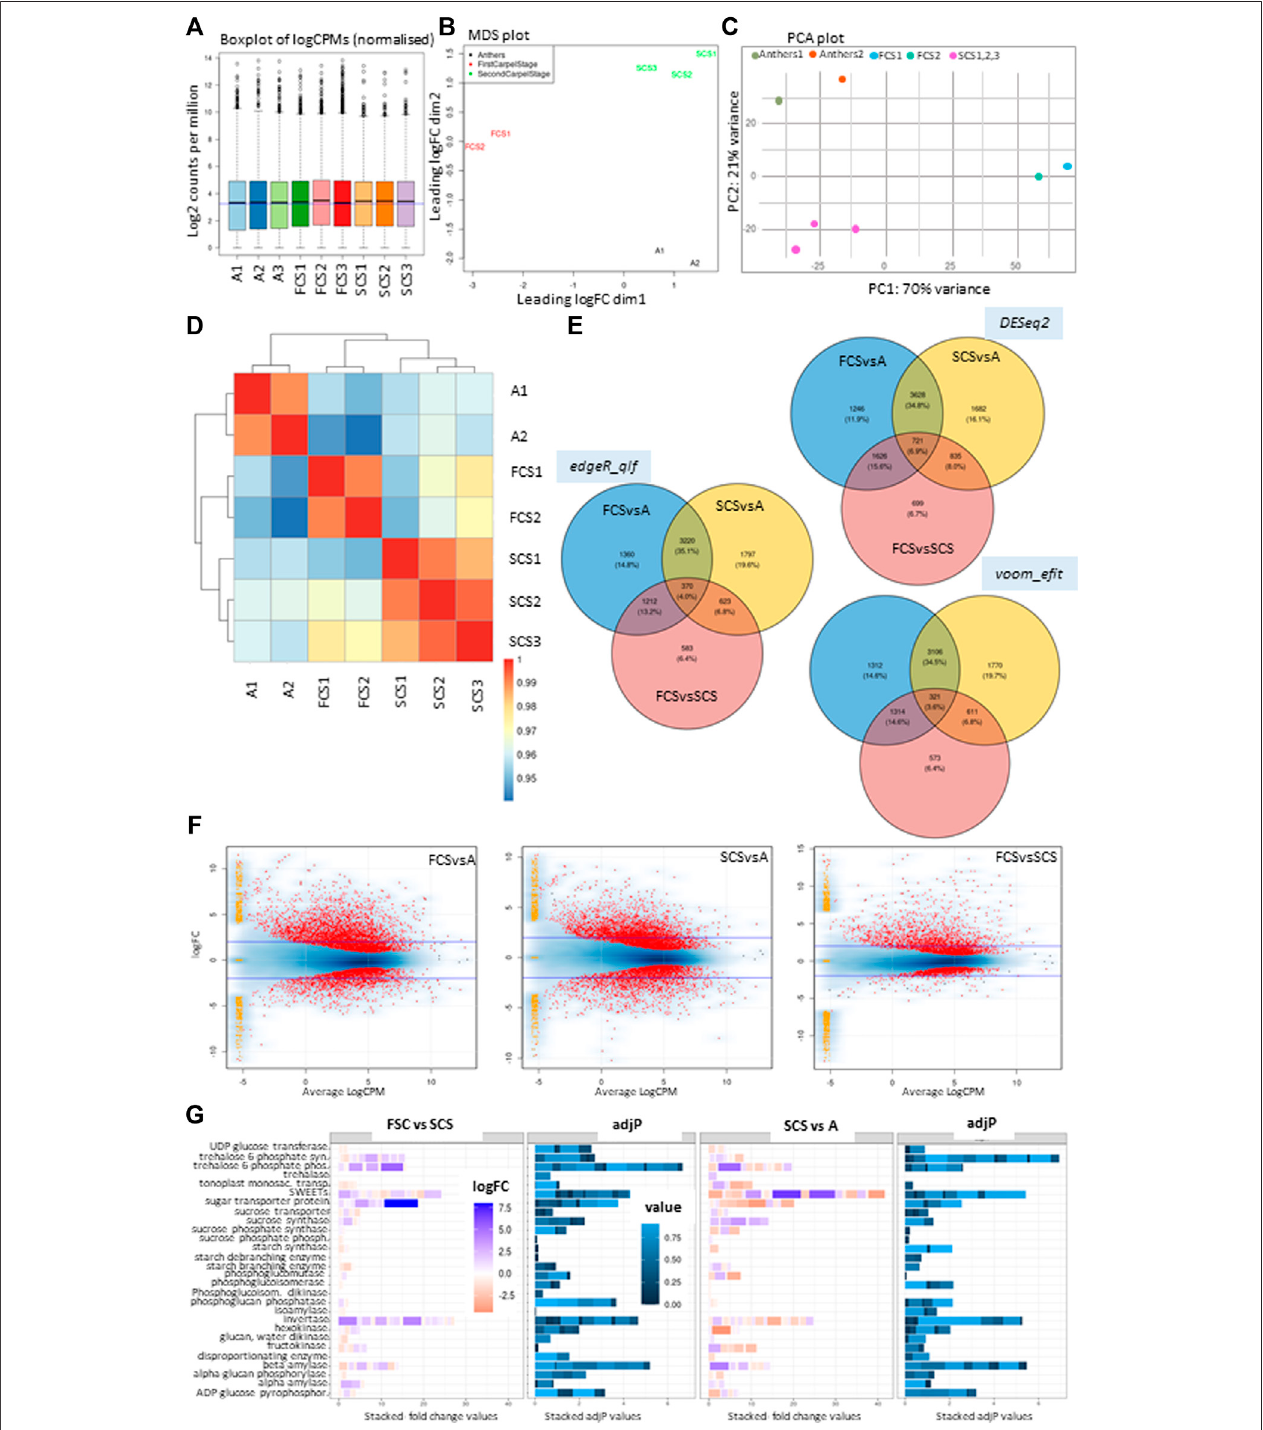
FIGURE2| Differentialexpression (DE)analysisofthetranscriptomes of Actinidia chinensis var. chinensis Russell ’ s immature anther and carpel tissues. (A) shows theboxplotoflogCPMsofnormalisedlibrariesforallsamples, (B) showsmultidimensionalscalinganalysisplot(MDS)forthesamplesselectedforDEanalysis, (C) shows the Principal component analysis, and (D) shows the heatmap clustering of all the log-transformed raw counts from samples selected. (E) shows Venn diagram for DE genes between three tissues, using three independent methods including edgeR (test-qlf, FDR < 0.05), DESeq2 (padj < 0.05) and voom (test-e fi t, padj < 0.05). (F) shows smearplots for DE genes, highlighted in red at p value ≤ 0.01 with ablue line marked at logFoldChange (logFC) ±2, in apair-wise analysis of tissues of First Carpel Stage (FCS) vs. Anther (FCSvsA), Second Carpel Stage (SCS) vs. Anther (SCSvsA) and First Carpel Stage vs. Second Carpel Stage (FCSvsSCS) using edgeR.